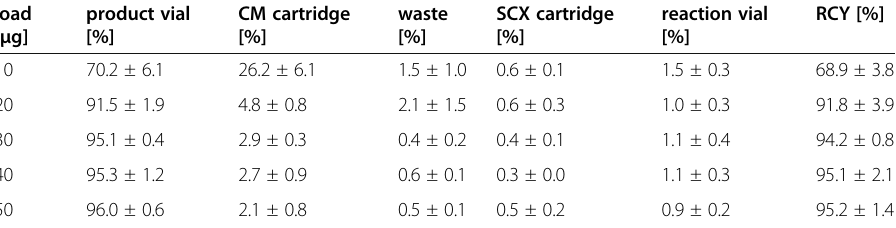
Table 1 Activity measured on different parts of the cassette immediately after synthesis on MLPT ( n = 3) load [ μ